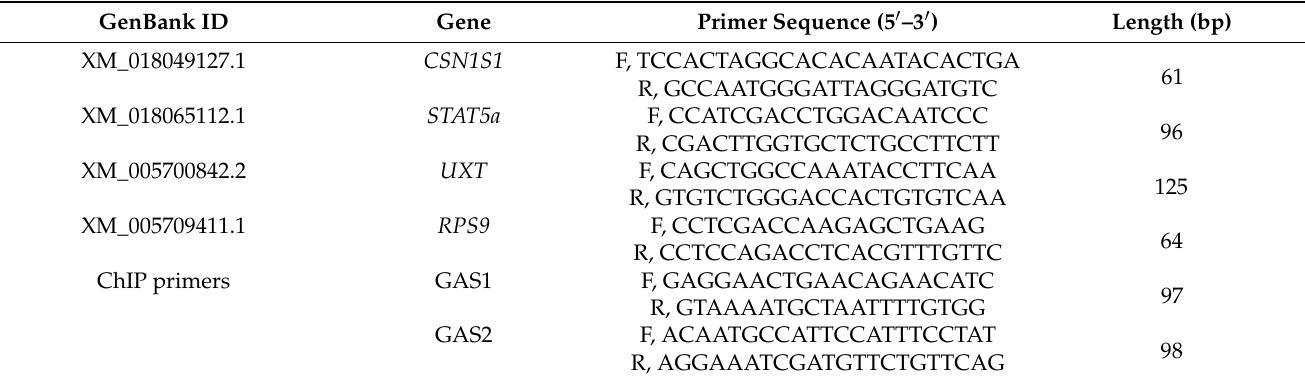
Table 2. Primers used for quantitative real-time